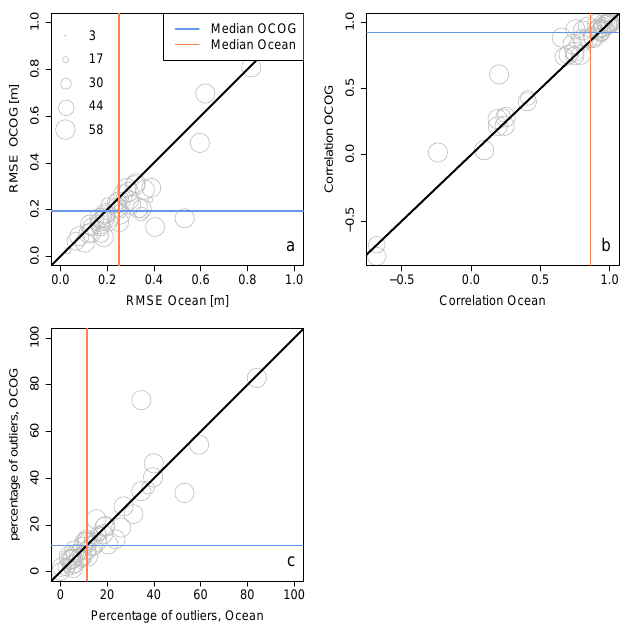
Figure 2. Scatter plot of ( a ) root mean squared error (RMSE) values, ( b ) Pearson correlation, and ( c ) percentage of outliers for the US lakes. The vertical orange and blue lines represent the median RMSE values for the Ocean and Offset Centre of Gravity Retracker (OCOG) retrackers, respectively. The size of the circles indicates the number of cycles used in the calculation of the summary measures. In order to detail the findings, only RMSE values below 1 m are